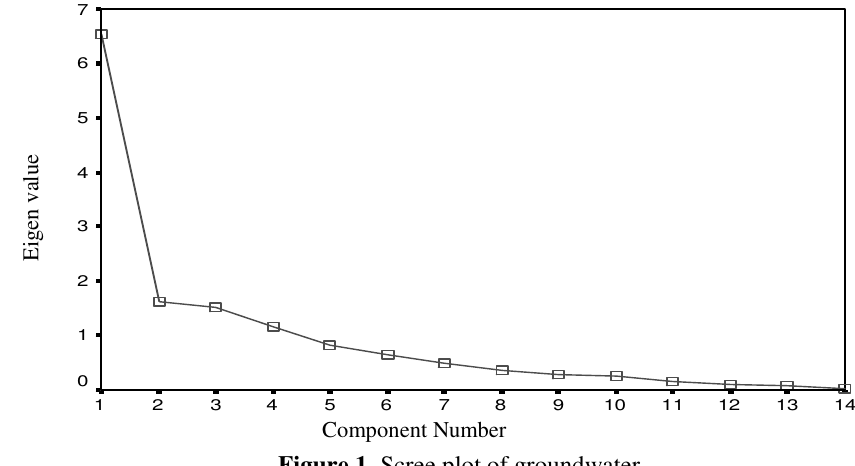
Figure 1. Scree plot of groundwater